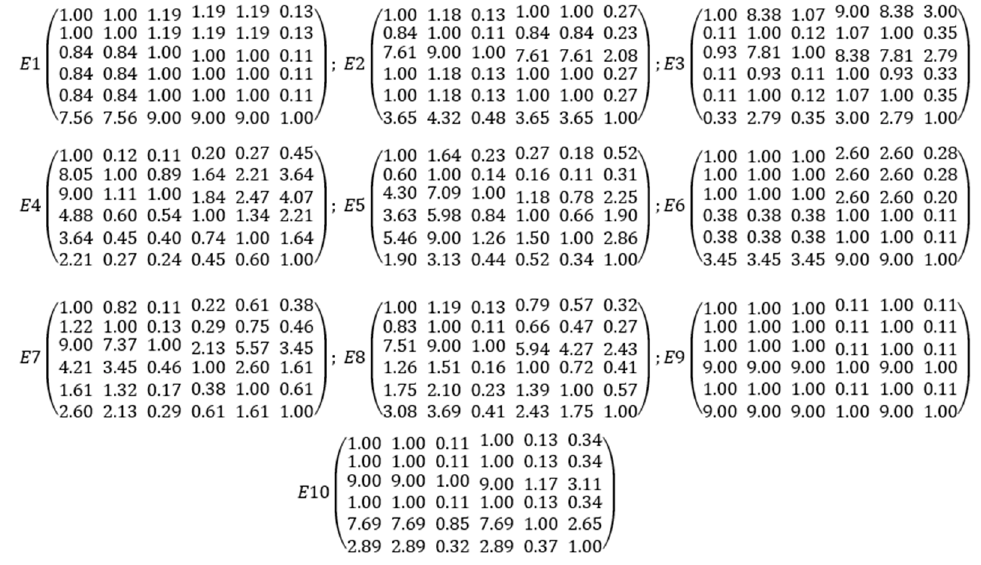
Figure 4. Pairwise comparison matrices from expert’s preference relations, based on AHP.